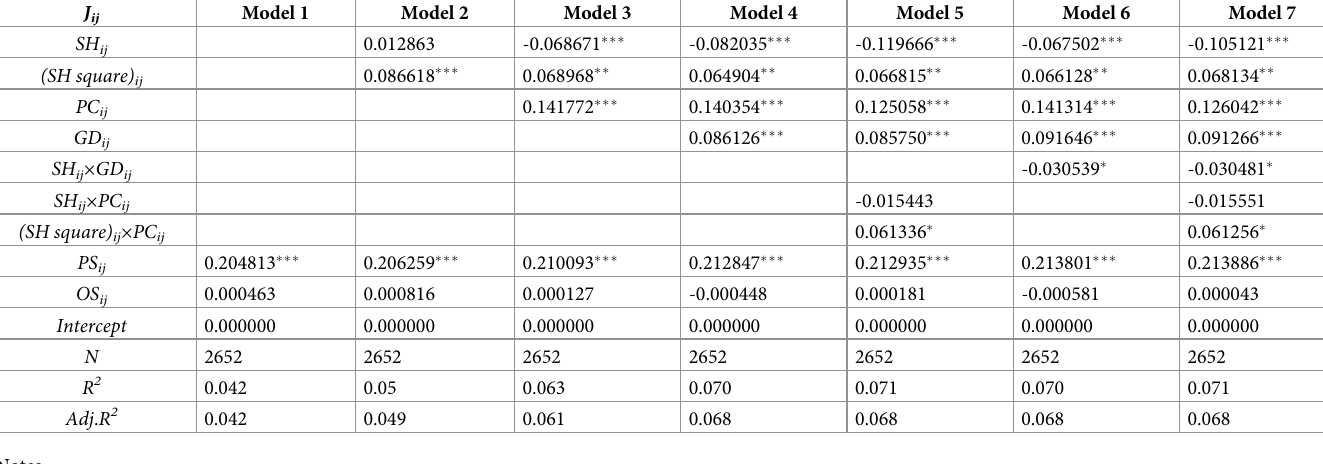
Table 7. QAP regression results for technology